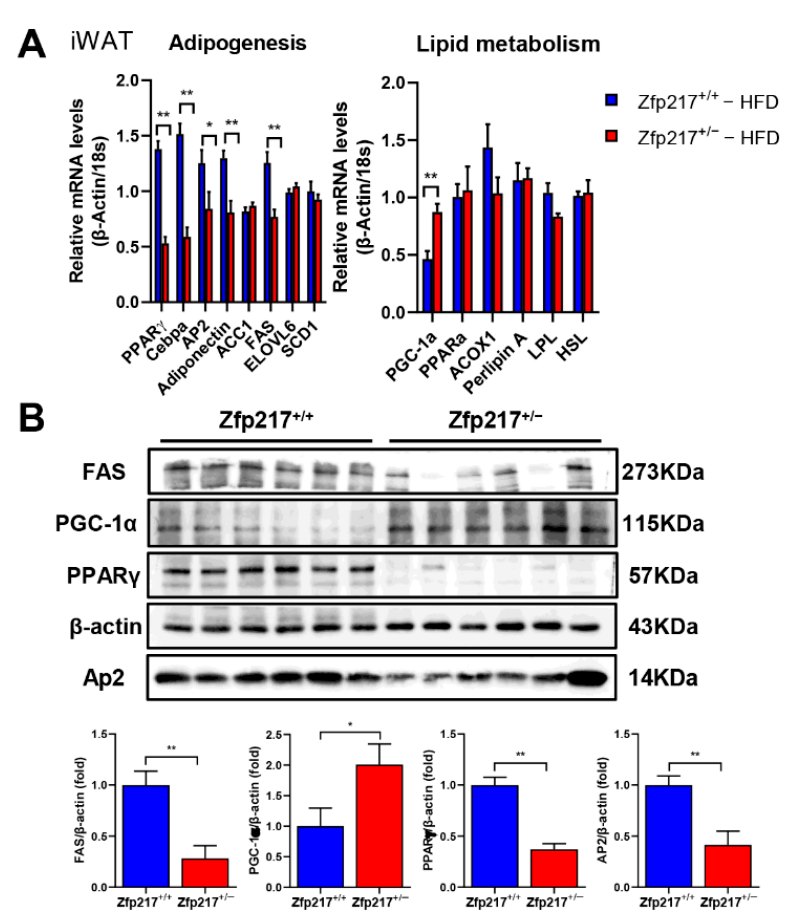
Figure 5. Gene expression in the iWAT of Zfp217 +/+ and Zfp217 +/ − mice fed a high-fat diet. ( A ) Quantitative real-time PCR analysis of genes involved in adipogenesis and lipid metabolism in iWAT of Zfp217 +/+ and Zfp217 +/ − mice fed an HFD. Expression data were normalized to β -actin and the 18 S geometric mean in each sample ( n = 6 per group). ( B ) Western blotting analysis of genes involved in adipogenesis and lipid metabolism in iWAT of Zfp217 +/+ and Zfp217 +/ − mice fed an HFD. Expression data were normalized to the β -actin geometric mean in each sample ( n = 6 per group). For all statistical plots, data are presented as the mean ± SEM. * p < 0.05; ** p < 0.01.